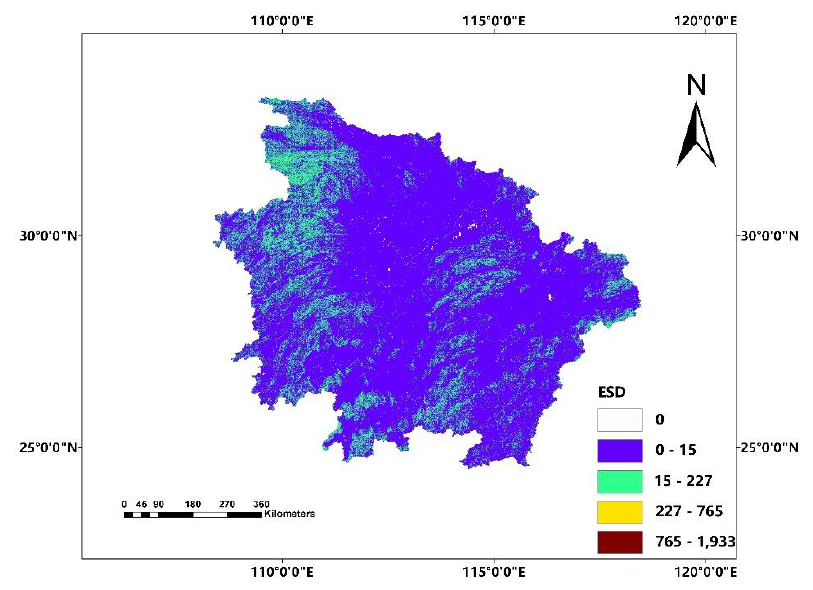
Figure 6. Elevation standard deviation.